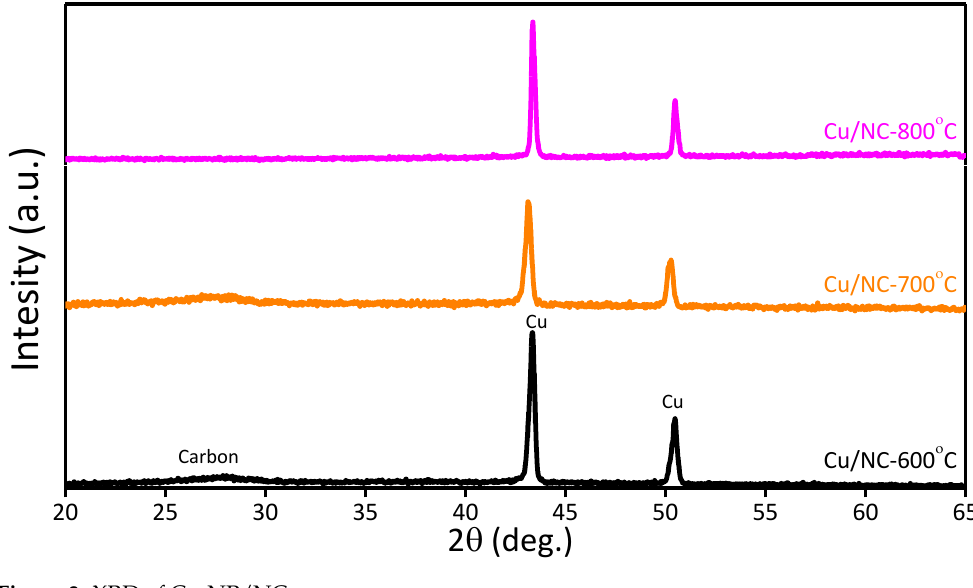
Figure 3. XRD of Cu-NP/NC.